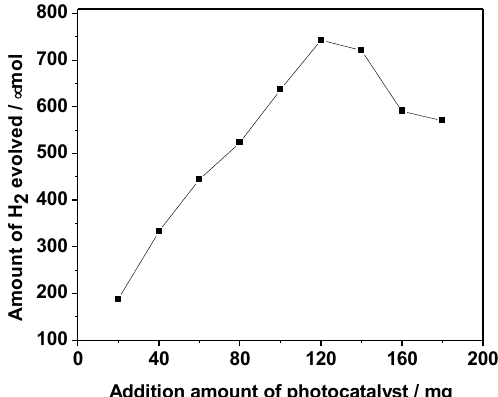
Figure 7. Effect of the addition amount of the 1.5% CuO-SrTiO 3 photocatalyst on the photocatalytic activity for hydrogen evolution.The amount of methanol: 60 mL, 60 vol.%; reaction temperature: 45 °C; irradiation time: 2 h.